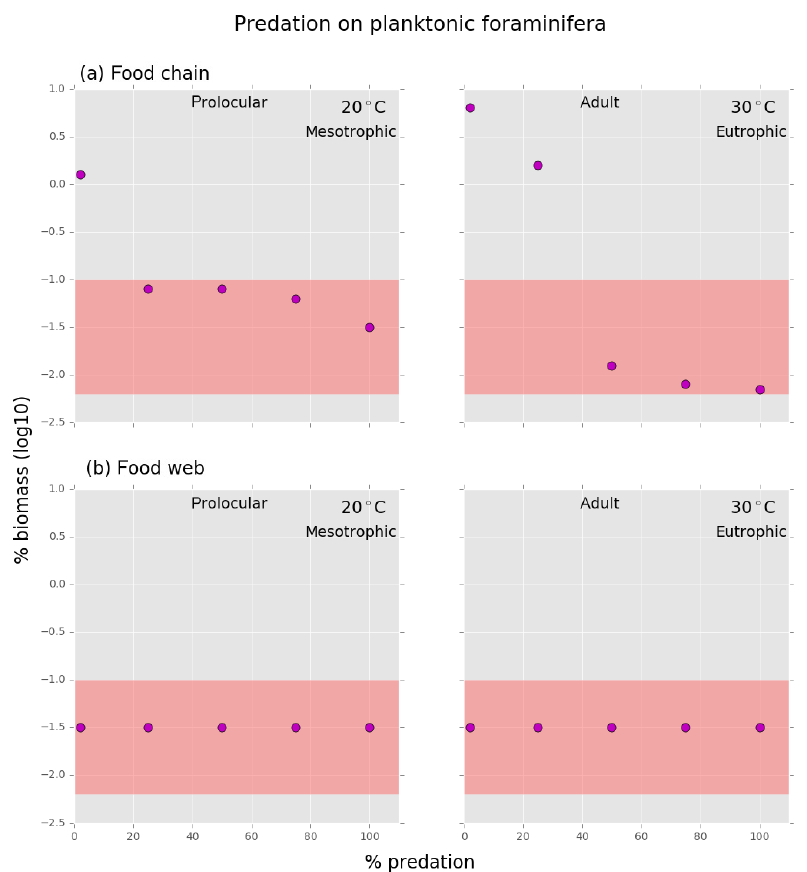
Figure B2. Results from the (a) food chain and (b) food web for different predation on planktonic foraminifera. Within the coloured frame are the different grazing pressures on planktonic foraminifera for which their relative biomass is within the defined range (0.007% to